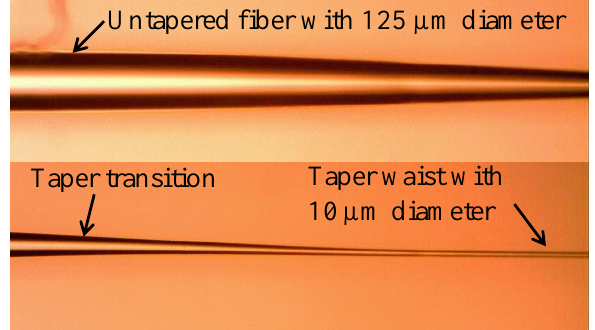
Figure 4. A typical fabricated tapered fiber. The untapered fiber was 125 µm of diameter, and the taper waist was about 10 µm of diameter. The taper transition region had